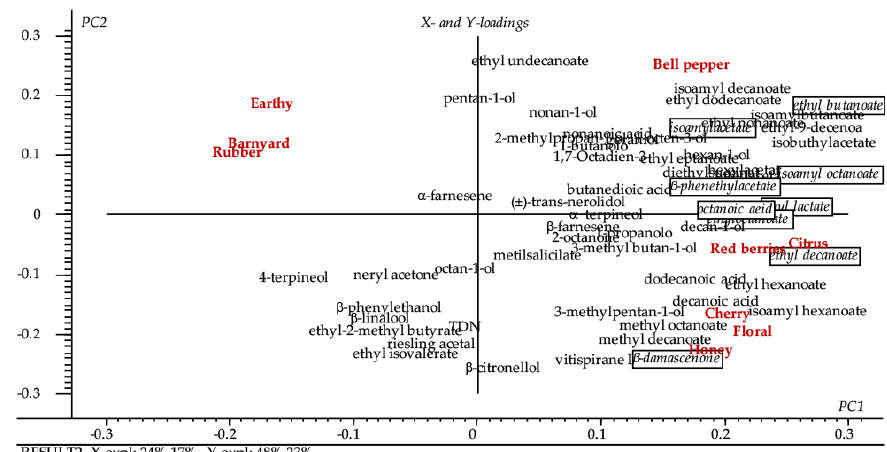
Figure 7. Partial least square regression (PLS-2) model for prediction of identity sensory attributes of